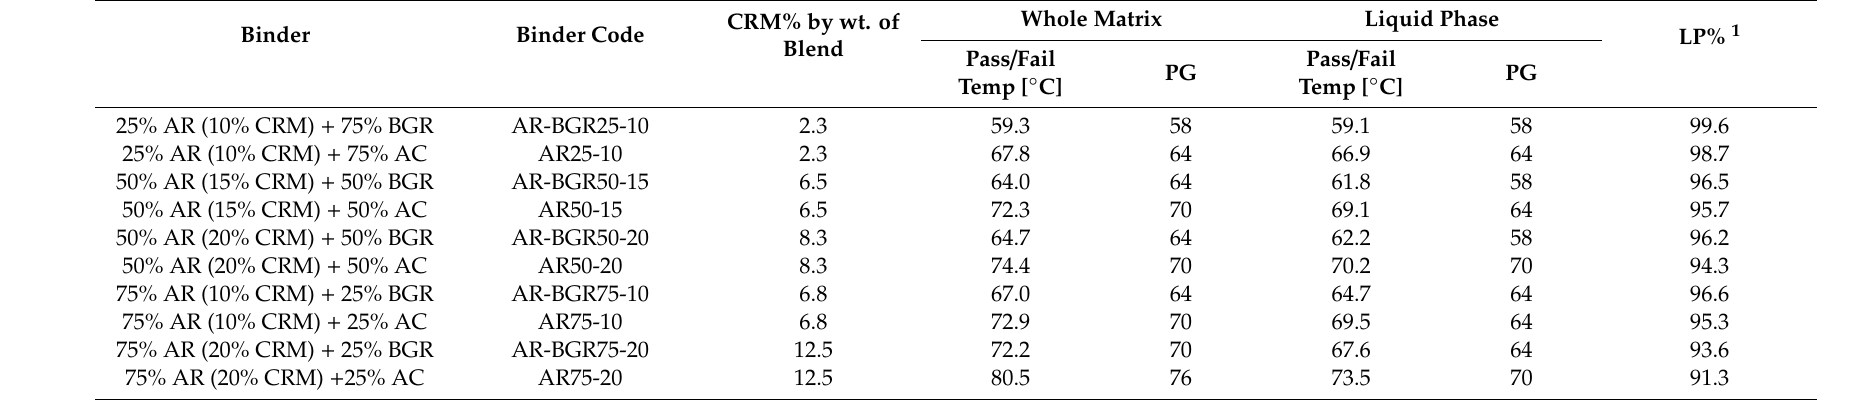
Table 4. Whole matrix vs. liquid phase grade